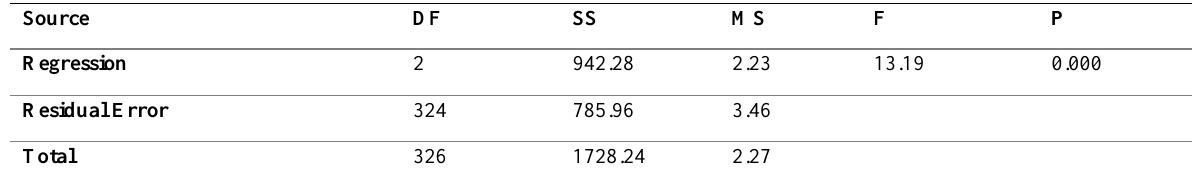
Table 2: Simultaneous Parameter Significance Test